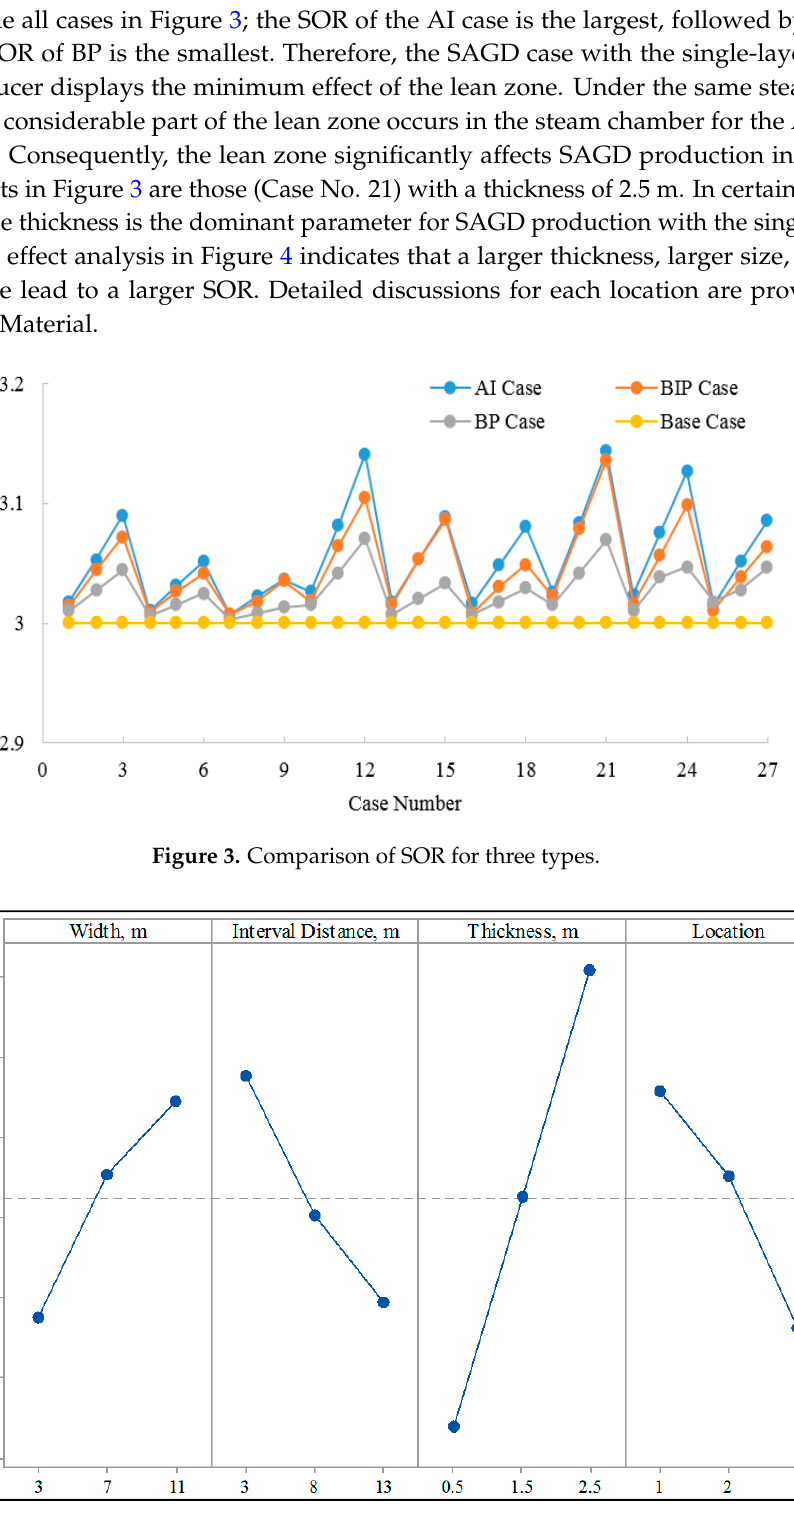
Figure 4. Main effect analysis of SOR for all cases.